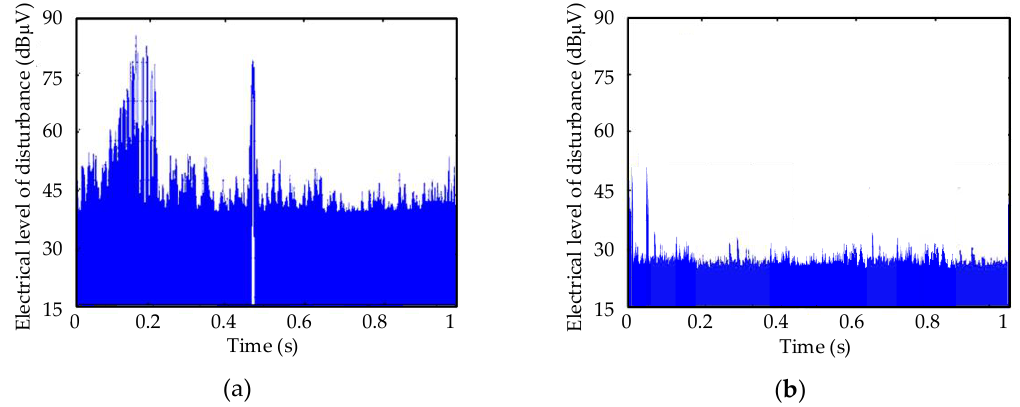
Figure 6. Disturbance in BTM system when the train passes through phase separation zones: ( a ) The disturbance received by the antenna. ( b ) The disturbance in BTM system when the antenna is disconnected.